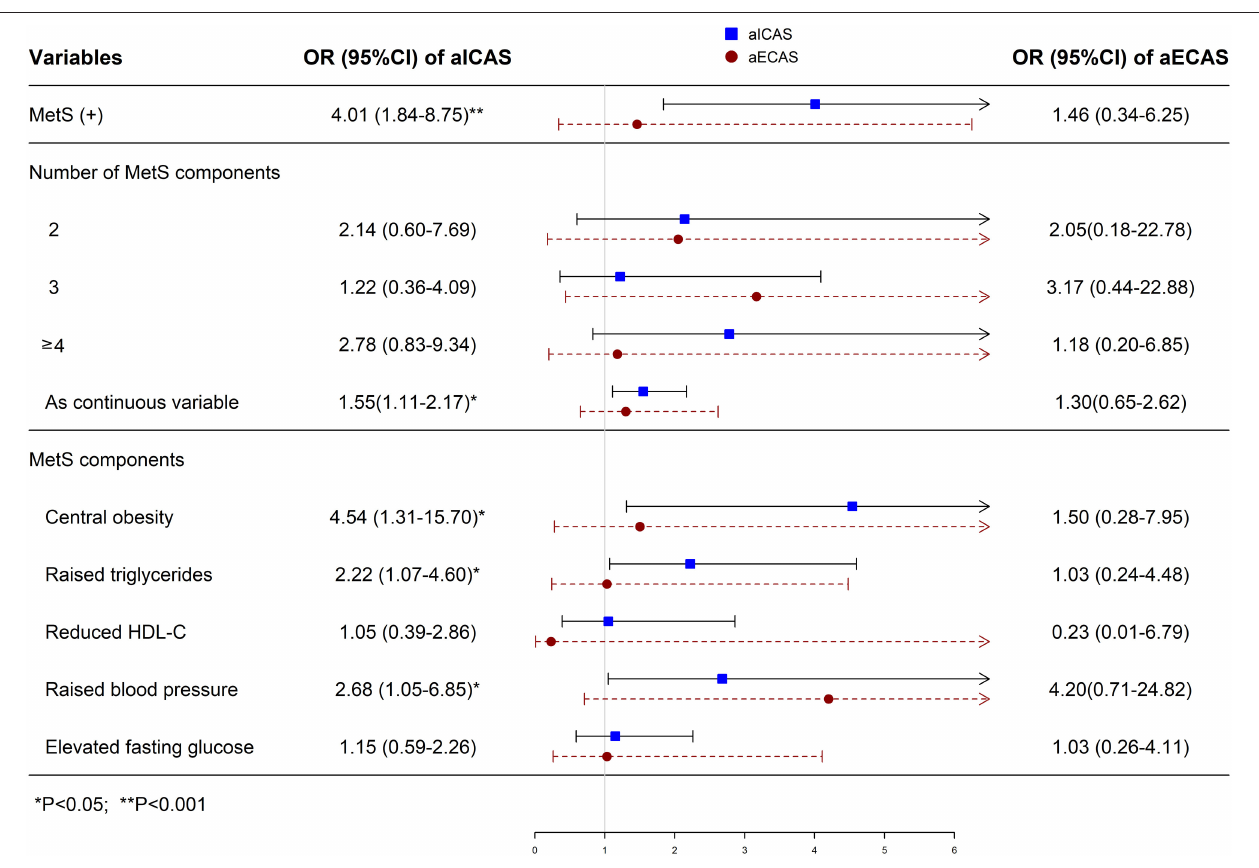
FIGURE 1 | Multivariate logistic regression analysis of the association of MetS with aICAS or aECAS. aICAS, asymptomatic intracranial arterial stenosis; aECAS, asymptomatic extracranial arterial stenosis; LDL-C, low-density lipoprotein cholesterol; HDL-C, high-density lipoprotein cholesterol; BMI, body mass index; BP, blood pressure; MetS, metabolic syndrome; OR, odds ratio. ORs were calculated using logistic regression model after adjusting total cholesterol, BMI, and